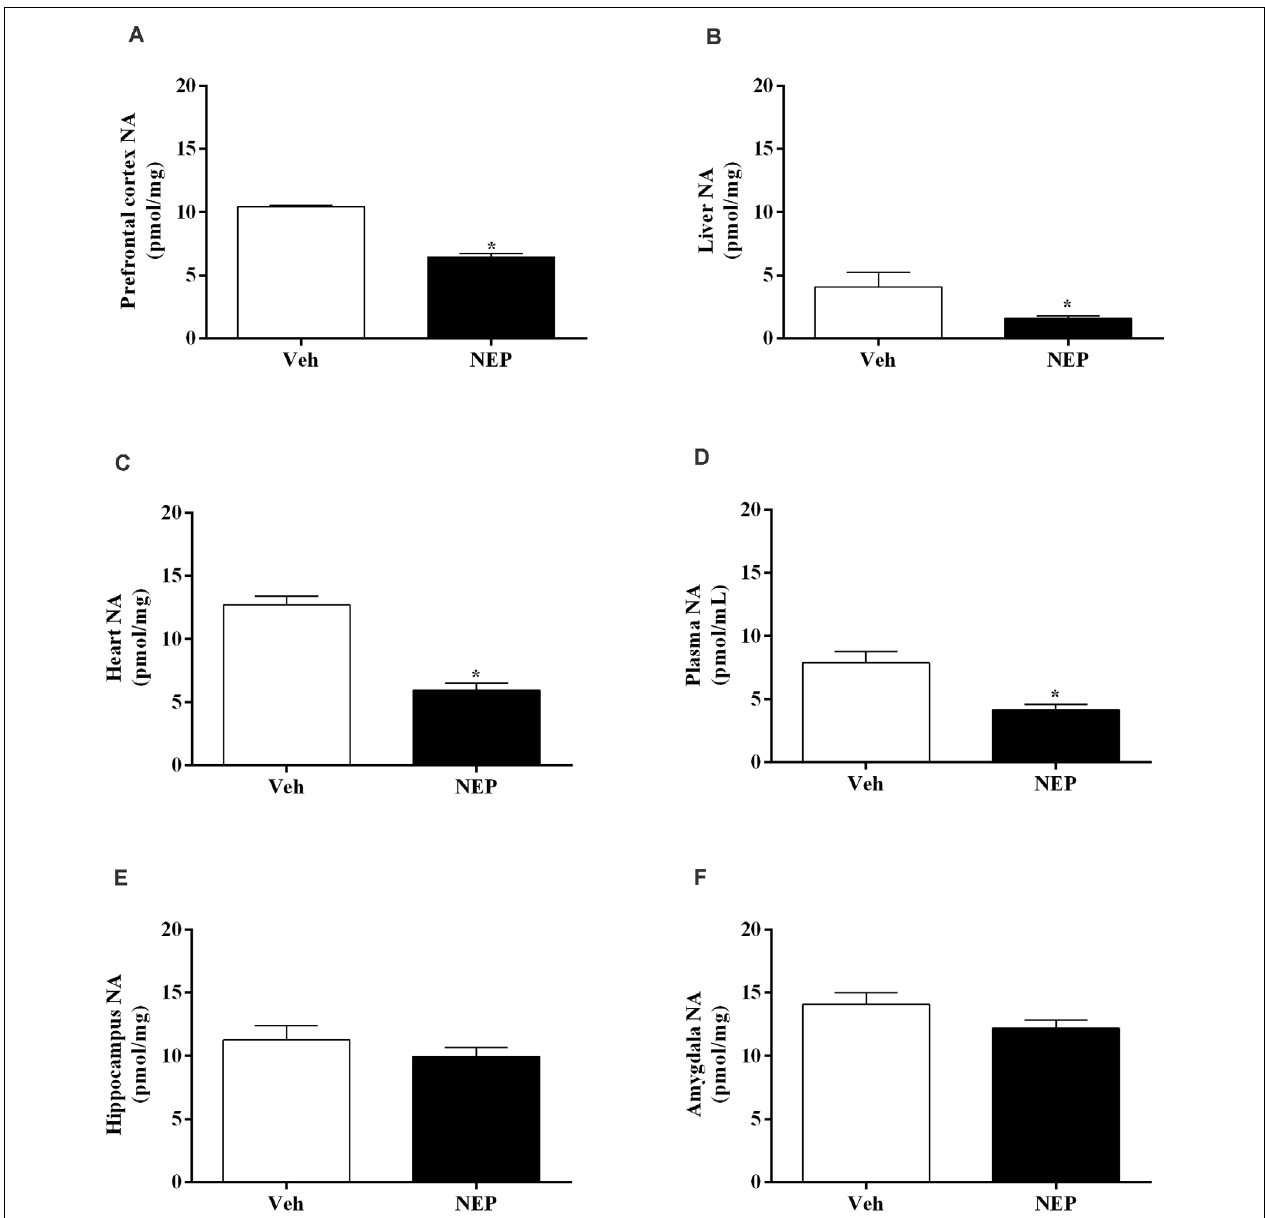
FIGURE 7 | Noradrenaline (NA) concentration in the (A) prefrontal cortex, (B) liver, (C) heart, (D) plasma, (E) hippocampus, and (F) amygdala in mice induced with post-traumatic stress disorder (PTSD). Values are means ± SEM of eight mice per group. Veh, mice in the PTSD-group and treated with vehicle; NEP, mice in the PTSD-group and treated with nepicastat; *, significantly different from correspondent values in mice in the PTSD-group and treated with vehicle ( p <